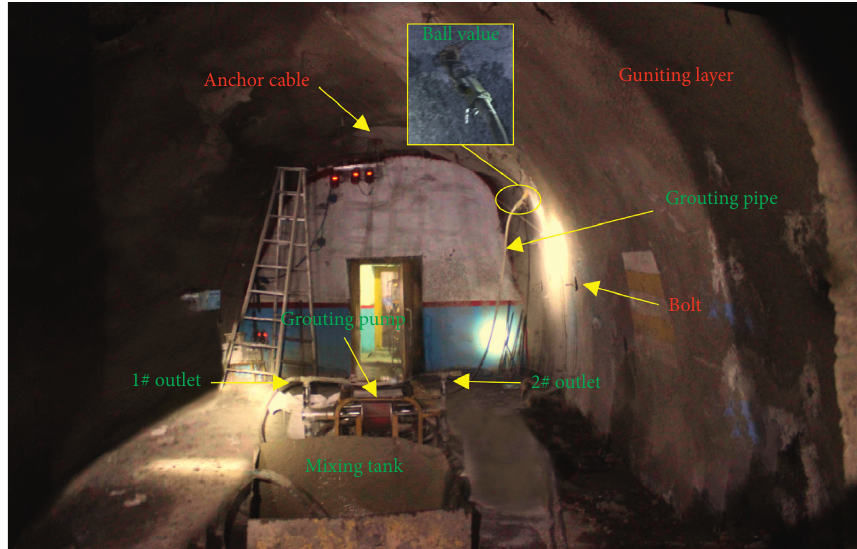
Figure 8: Grouting